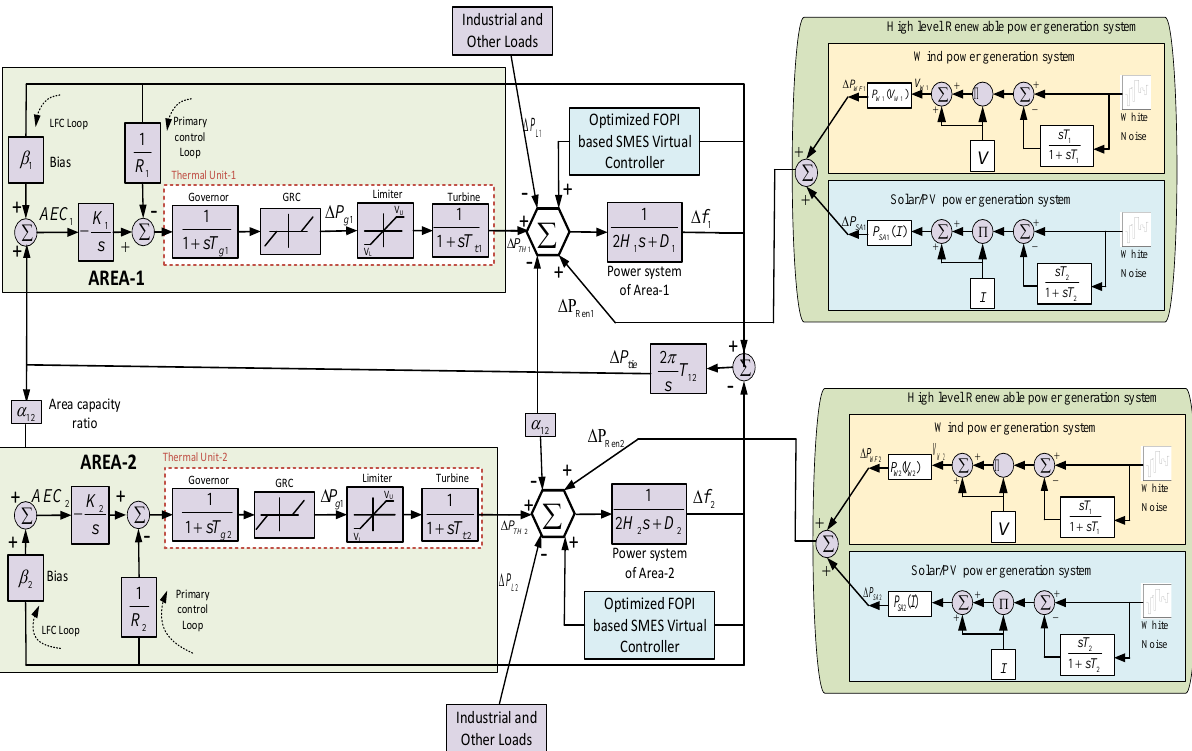
Figure 2. The dynamic model of two area system with proposed